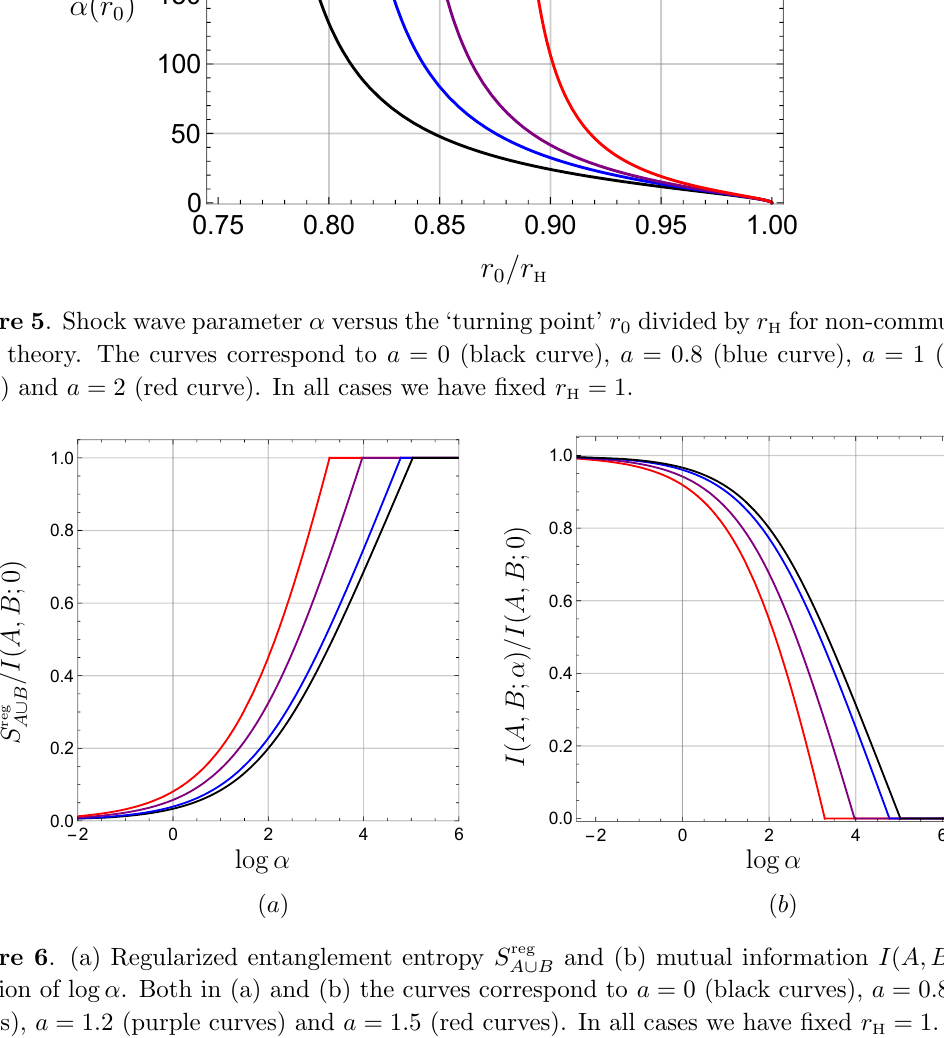
and (b) mutual information I ( A; B ) as a A [ B = H